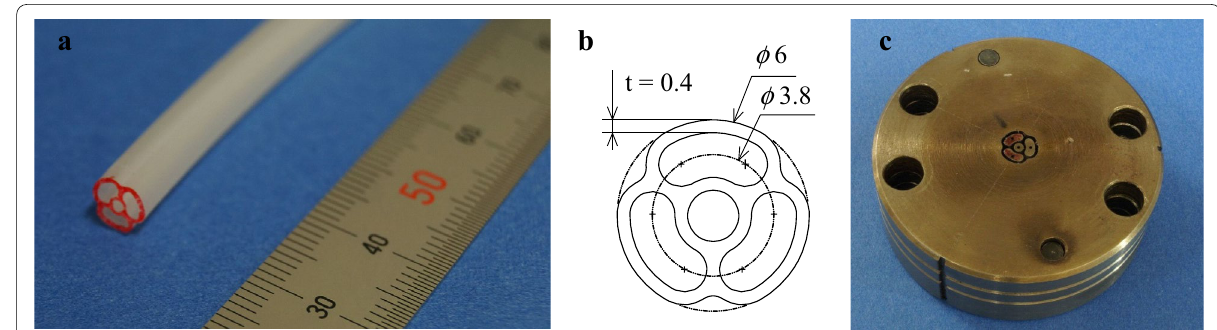
Fig. 16 Used soft robot. a Cut surface of the actual device. b Design of the mold. c Developed mold for the extrusion process to make the soft